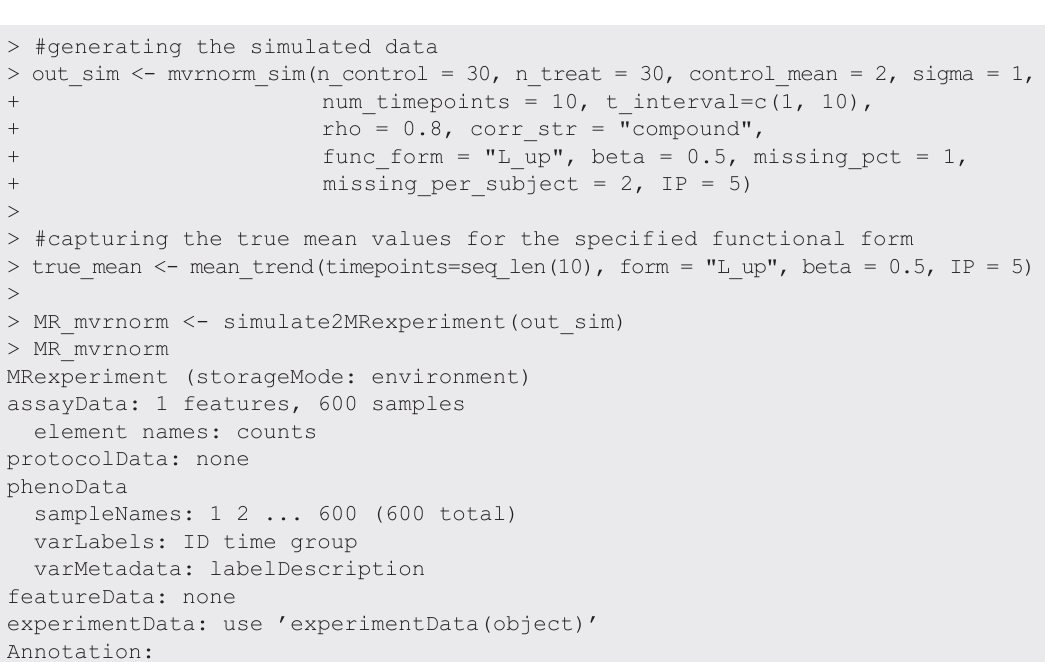
to here after as the metaSplines method. We start by generating our simulated data. In this example we will fix parameters to have q = 10 repeated measurements on each individual with n